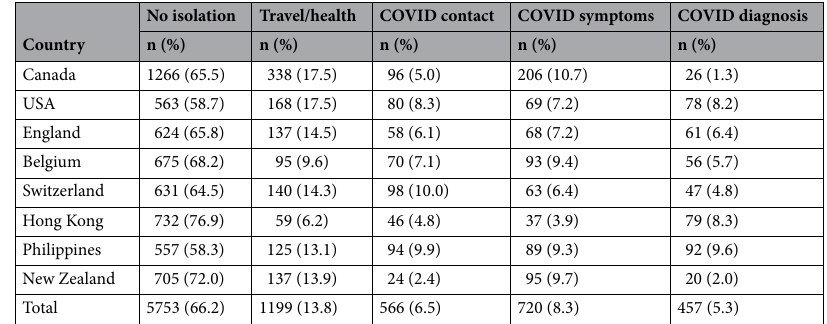
Table 2. Weighted distribution of participant’s response to COVID-19 induced quarantine and/or isolation questions overall and partitioned by country. 332 (3.7%) participants had missing data for quarantine and/or isolation questions.